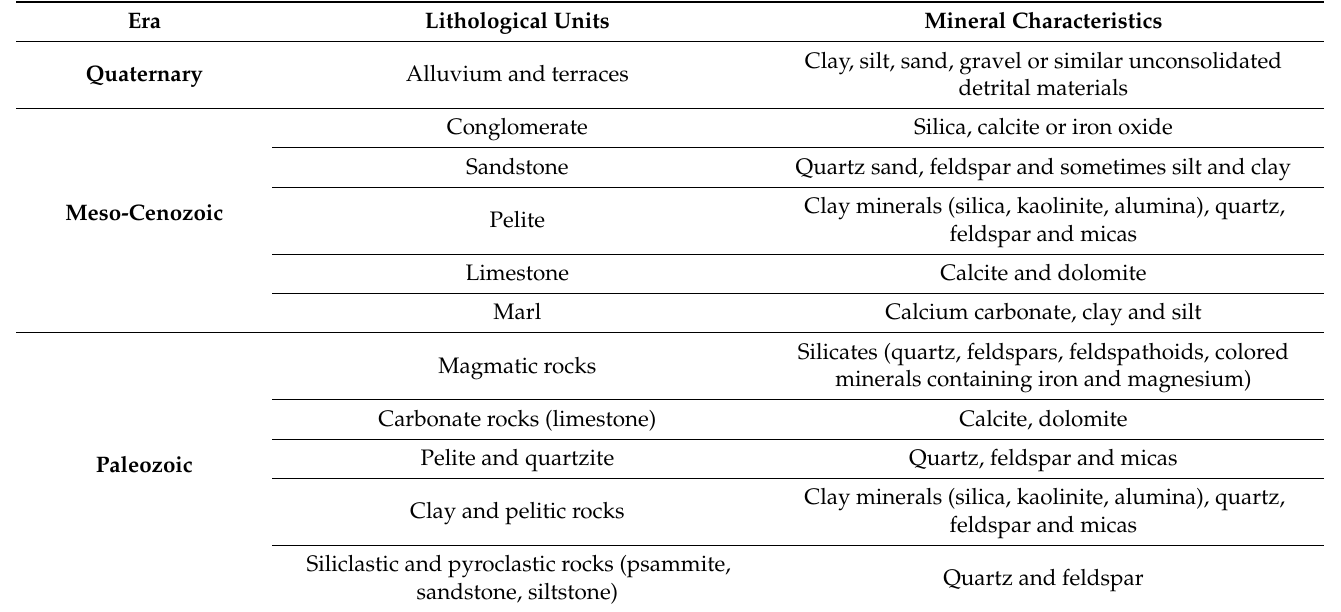
Table 2. Lithological and mineralogical description of the rock units in the study